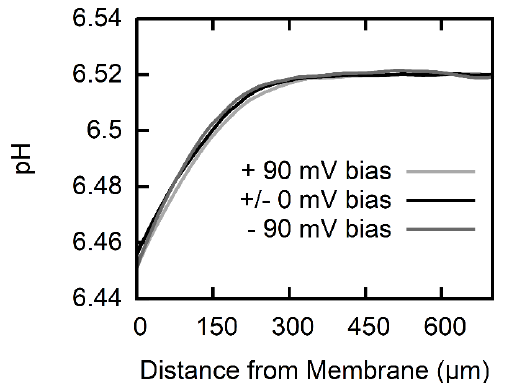
Figure 3. pH profiles at a constant AscH gradient (trace for 688 mM Na- L -ascorbate in Figure 2) under varying transmembrane voltage bias (black: no bias, light gray: +90 mV, dark gray: − 90 mV). The pH profiles are independent of the applied transmembrane voltage within the borders of resolution which attributes the pH profiles to the permeation of a neutral species.